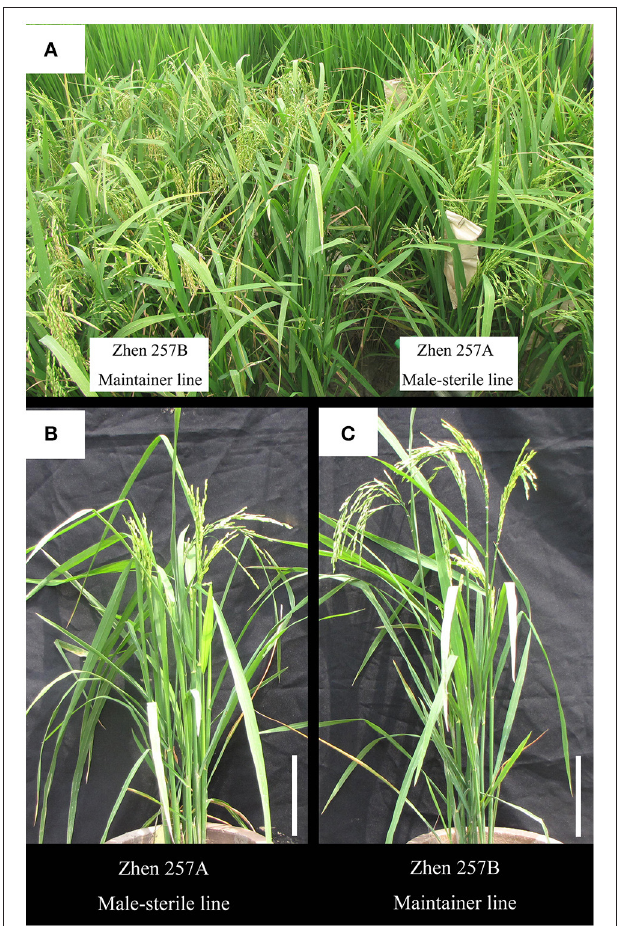
FIGURE 2 | Phenotypes of the maintainer line Zhen 257B, showing no panicle enclosure, and the male-sterile line Zhen 257A, showing panicle enclosure. (A) Plants of Zhen 257A and Zhen 257B at the filling stage on the plot. Individual plants of Zhen 257A (B) and Zhen 257B (C) at the filling stage. Scale bar,